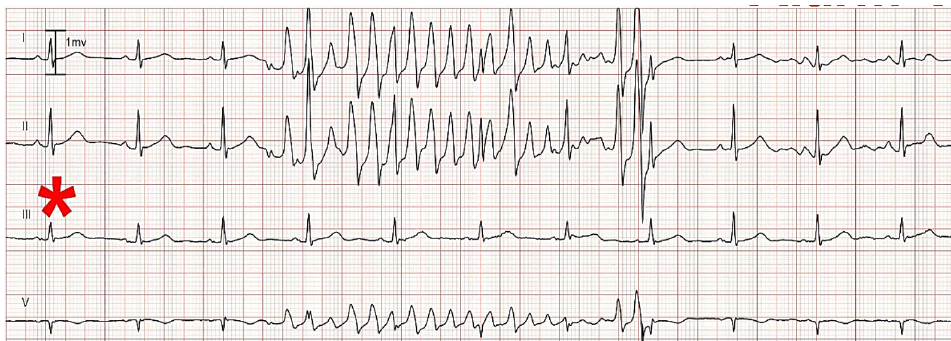
Figure 5. False alarms for ventricular fibrillation. As noted by the *, in lead III, this patient is in a normal sinus rhythm. This particular manufacturer requires a clean ECG signal in at least two ECG leads. Figure from the ECG Monitoring Research Lab, UCSF School of Nursing.